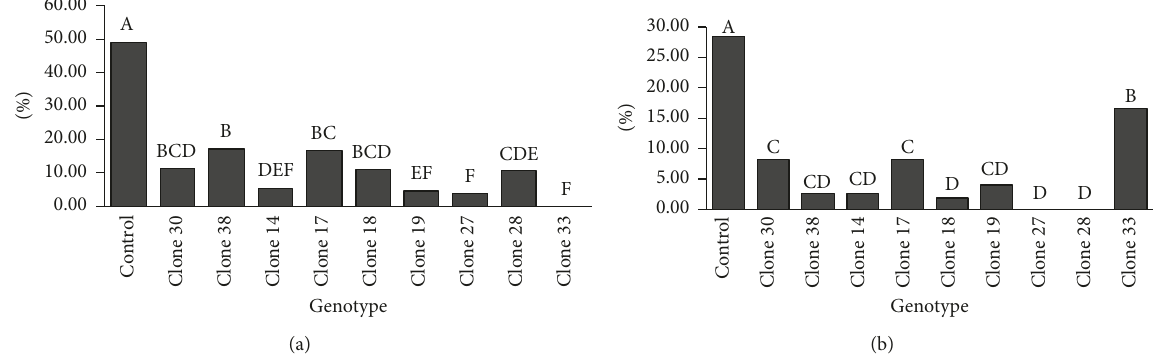
Figure 4: Evaluation of ten selected bunching onion genotypes for (a) downy mildew and (b) root rot disease severity.